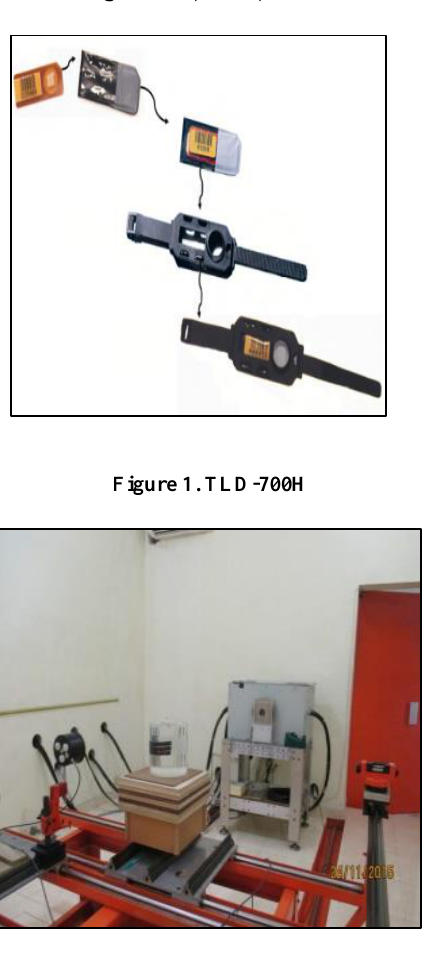
Figure 3. YXLON-MG325 X-Ray Figure 4.